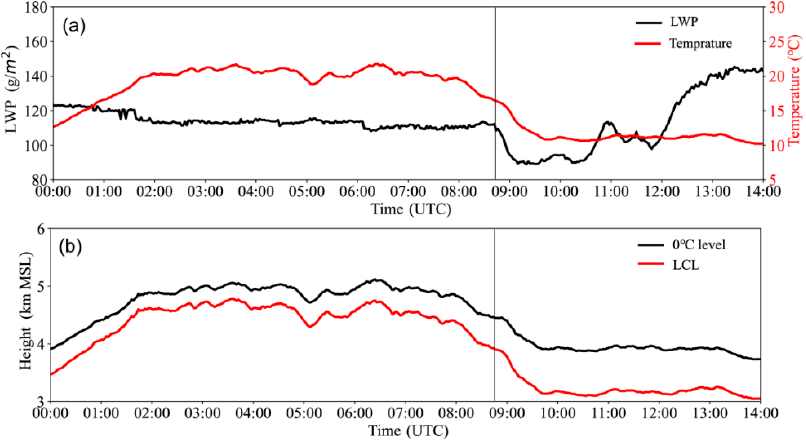
Figure 3. Time series of ( a ) temperature near surface (red) and liquid water path (black); ( b ) Freezing level height (black) and LCL height (red) from 0:00 to 14:00 UTC derived from the radiometer measurements. The vertical line in each panel indicates the starting time of precipitation over the Mushi